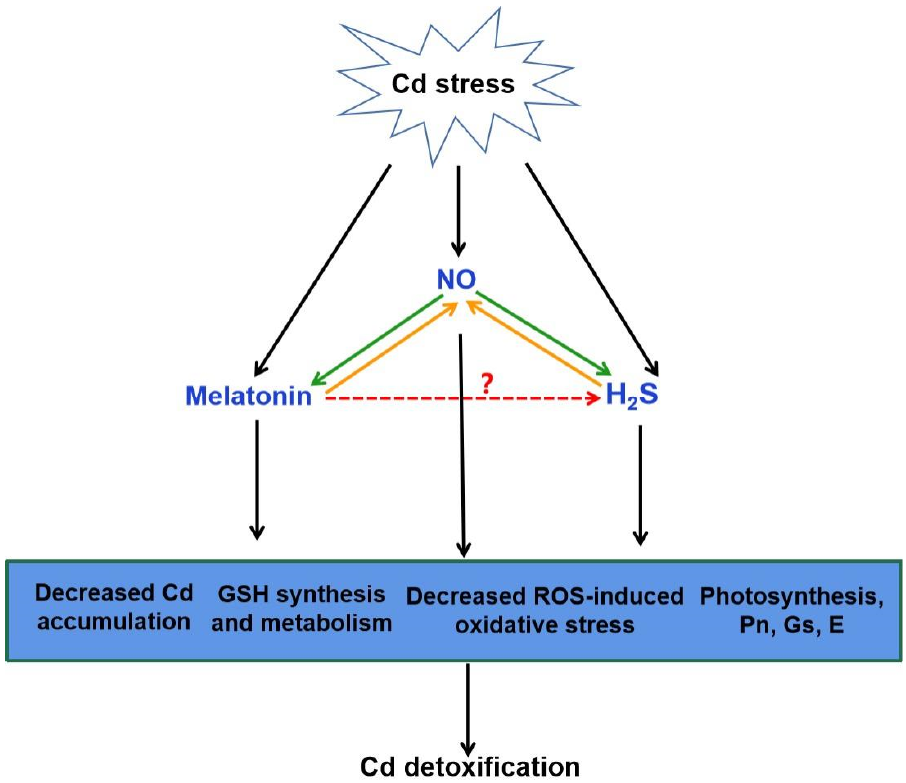
Figure 4. The possible role of H 2 S in melatonin-mediated Cd detoxification. NO generation can be induced by Cd stress. Increasing evidence showed that melatonin and H 2 S act as the downstream of NO in the responses to Cd stress, respectively (green arrow). It is also suggested that NO acts as a downstream of melatonin or H 2 S to improve Cd tolerance (orange arrow). The combination of melatonin, NO and H 2 S might be responsible for melatonin-triggered signal transduction in plant Cd tolerance via the decreased Cd accumulation, GSH synthesis and metabolism, decreased ROS-induced oxidative stress and improved photosynthesis. Red arrow, yet largely unknown. Cd, cadmium; NO, nitric oxide; H 2 S, hydrogen sulfide; GSH, glutathione; ROS, reactive oxygen species; Pn, photosynthesis rate; Gs, stomatal conductance; E,